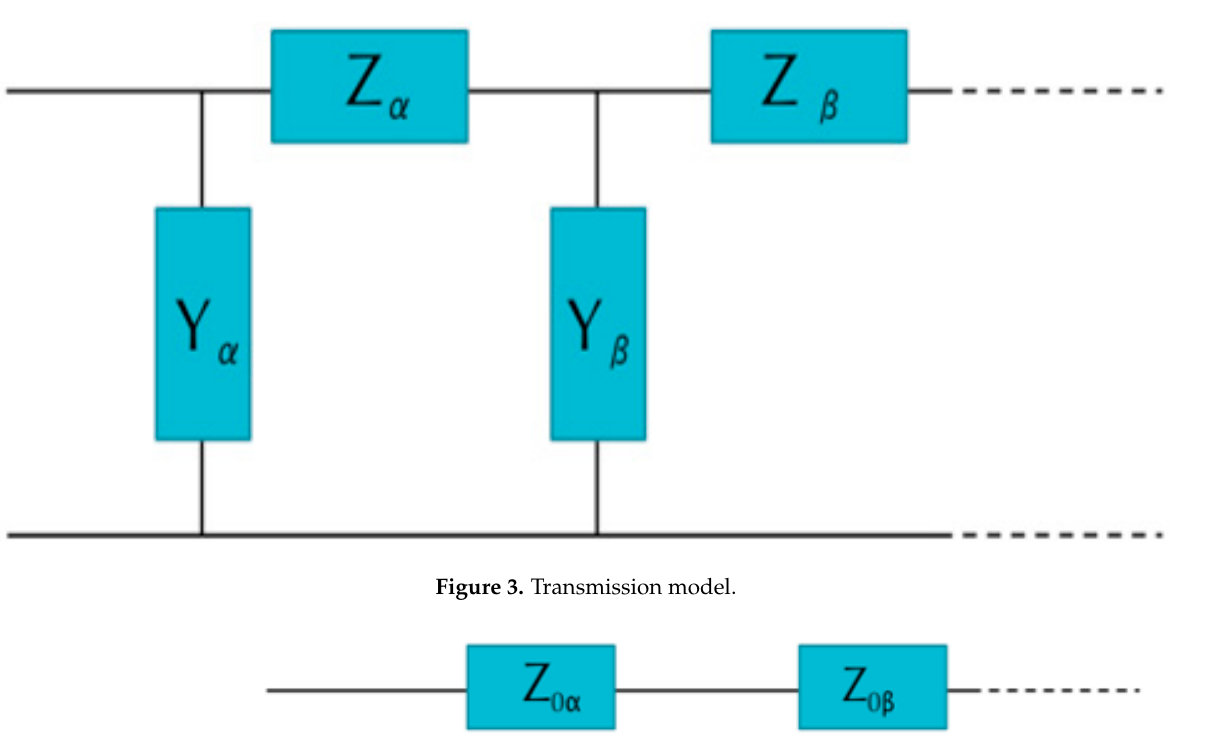
Figure 4. The equivalent transmission model used in the analysis.